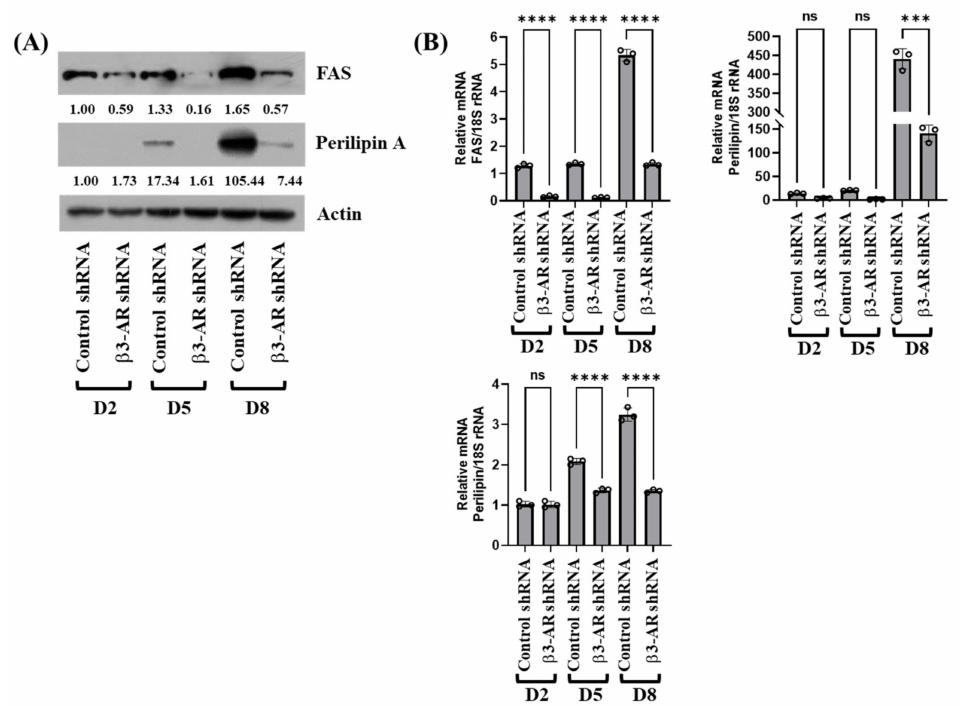
Figure 5. Effects of gene silencing of β 3-AR on the expression of FASN, perilipin A, and leptin at the protein and mRNA levels during 3T3-L1 preadipocyte differentiation. ( A ) 3T3-L1 preadipocytes were stably transfected with 100 pM of control or β 3-AR shRNA. Control or β 3-AR shRNA-transfected cells were differentiated with an induction medium containing MDI, insulin, and FBS, and harvested at day 0 (D0), D2, D5, and D8, respectively. At each time point, whole-cell lysates were prepared and analyzed by immunoblot analysis with respective antibodies. Relative intensities were measured by ImageJ software (version 1.8.0; National Institutes of Health, Bethesda, MD, USA). ( B ) 3T3-L1 preadipocytes were stably transfected with 100 pM of control or β 3-AR shRNA. Control or β 3-AR shRNA-transfected cells were differentiated with an induction medium containing MDI, insulin, and FBS, and harvested at day 0 (D0), D2, D5, and D8, respectively. At each time point, total cellular RNA was prepared and analyzed by real-time qPCR with respective primers. Error bars are indicated as mean ± SD. *** p < 0.001; **** p < 0.0001; ns, not significant, calculated by one-way ANOVA with Sidak’s multiple comparison